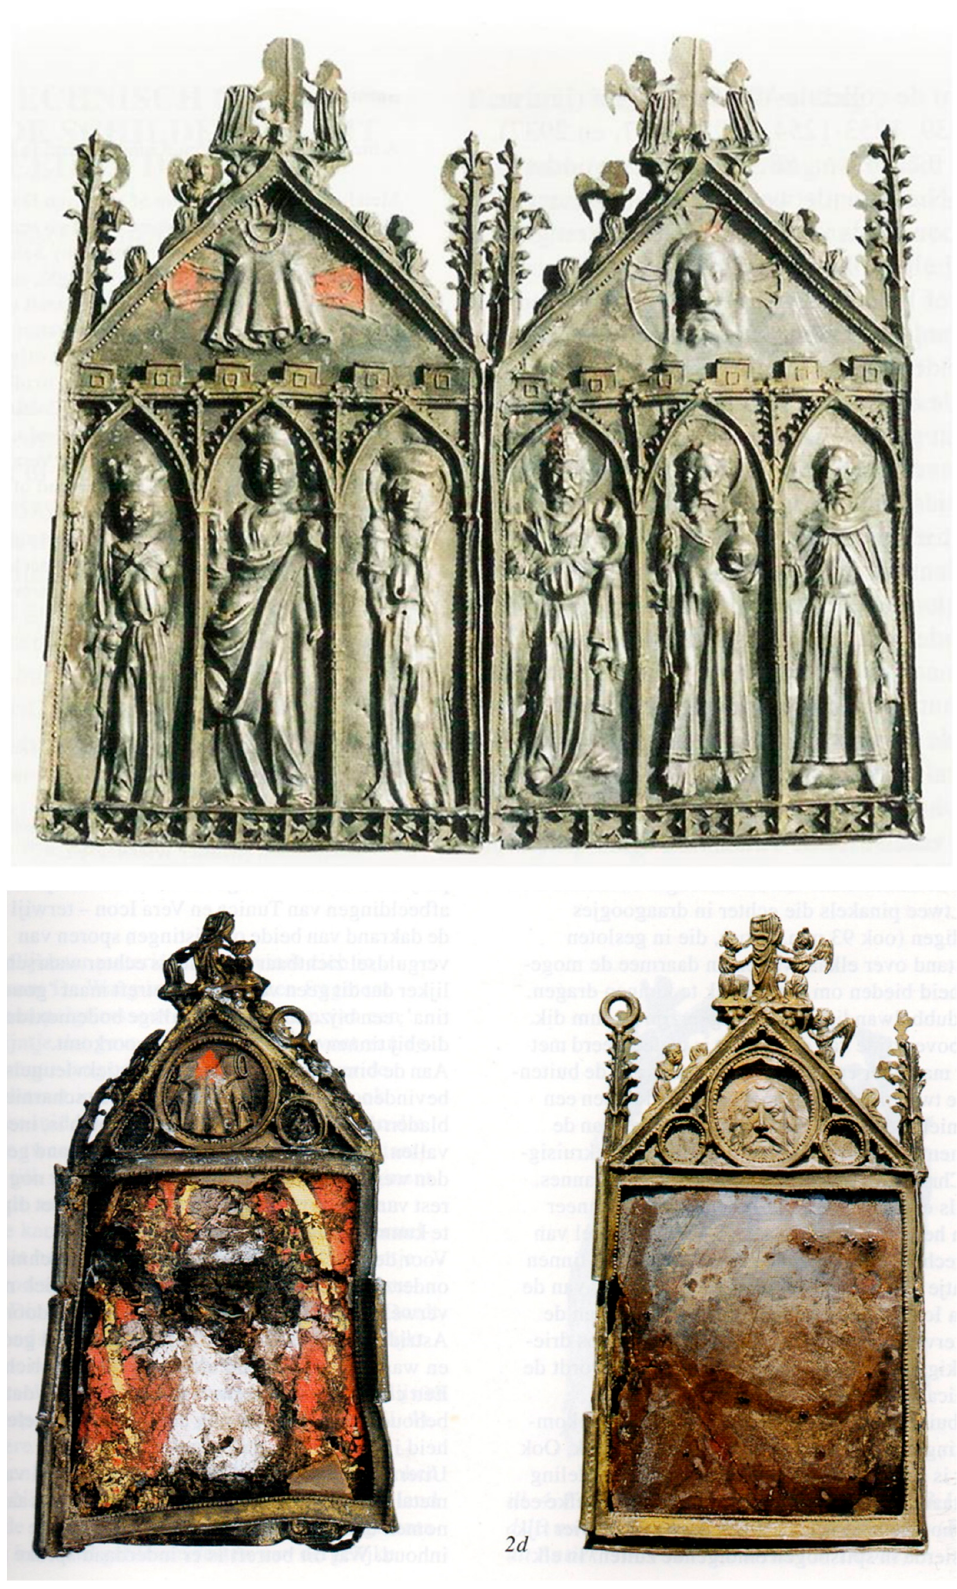
Figure 10. Pilgrim souvenir diptych from Aachen, Germany, late 14th/early 15th century, Cothen,